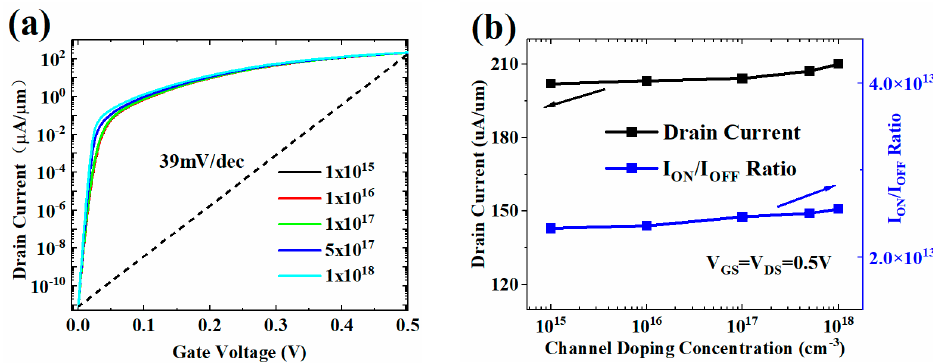
Figure 5. ( a ) Transfer characteristic and ( b ) I ON and I ON /I OFF with different N C values.